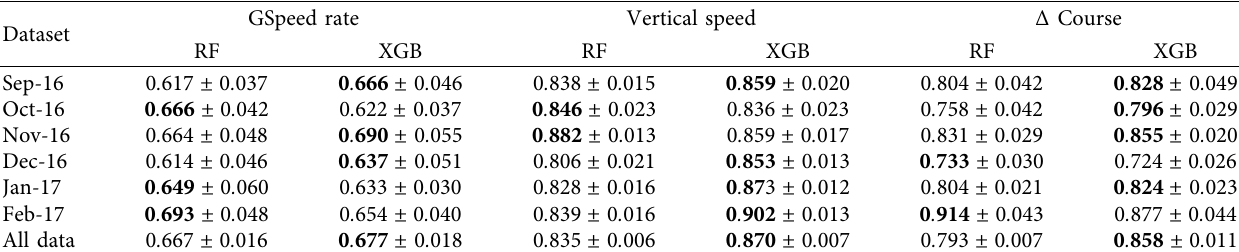
Table 5: Experiment results for predicting actions in R 2